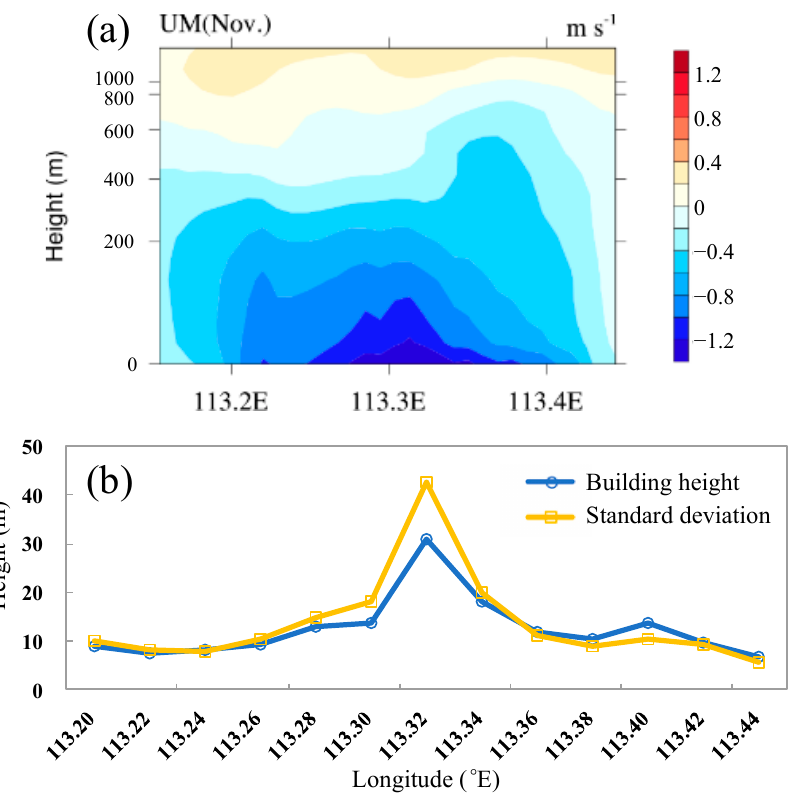
Figure 12. Impacts of the high-resolution UM on a vertical cross-section of the horizontal wind speed through 23.116° N ( a ) and the corresponding area-weighted mean building height and the standard deviation of the building height ( b ).